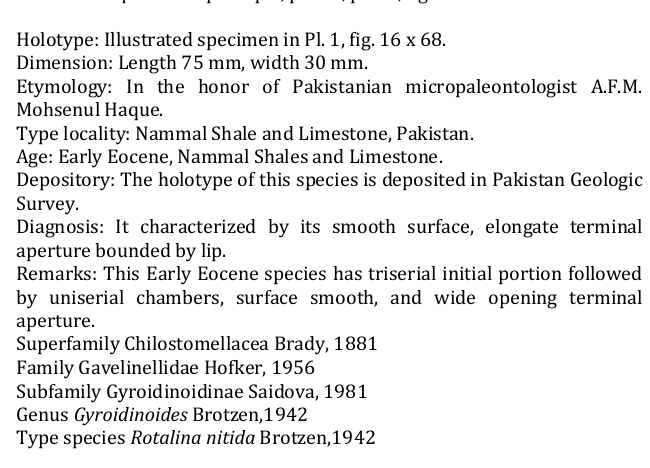
figure 10. 2019b Frondicularia nakkadyi Futyan - Anan, p. 260, pl. 1, figure